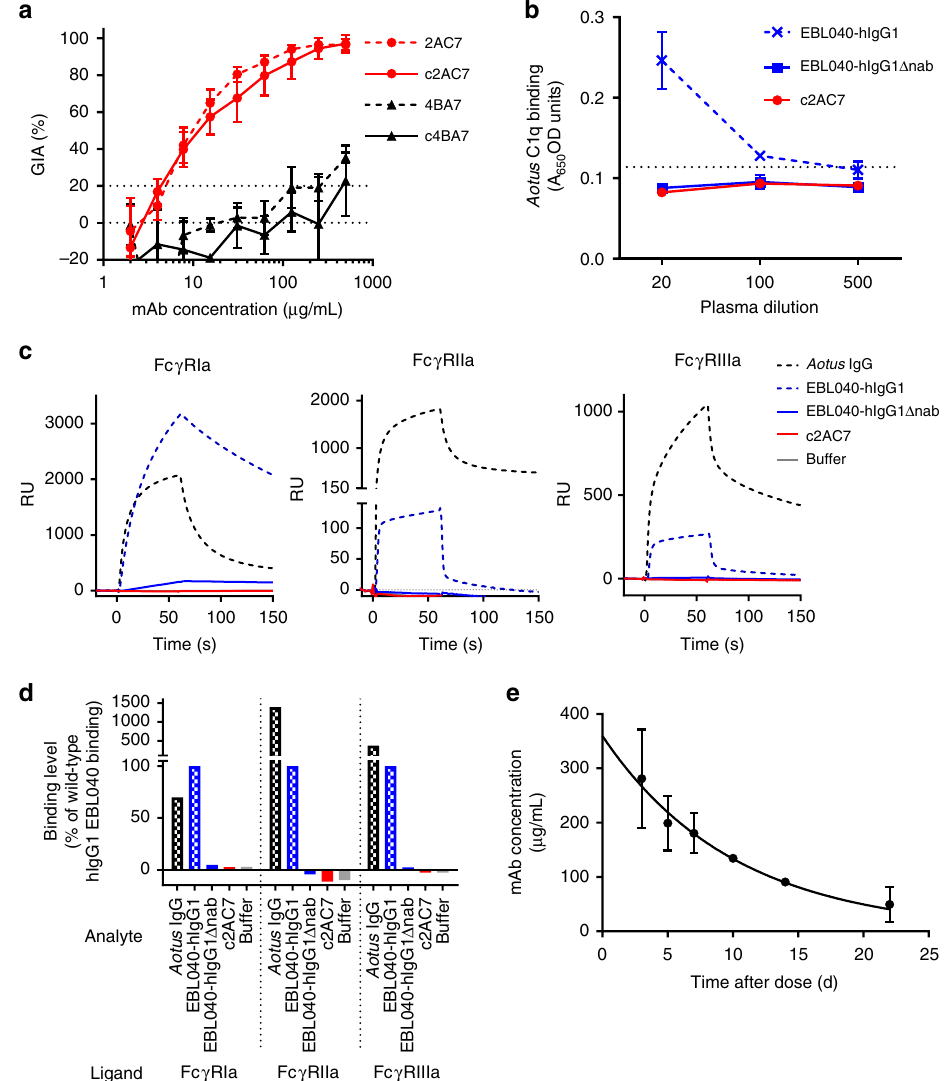
Fig. 1 Chimeric mAbs have desired properties for a challenge study. Panel a shows GIA with murine (dashed lines) and chimeric (solid lines) versions of 2AC7 (red lines) and 4BA7 (black lines) against FVO-strain parasites. Error bars indicate range of two independent experiments (with each experiment ’ s datum being the mean of three replicate wells); lines connect the mean of the experiments. Results of − 20 to 20% GIA are regarded as negative. Panel b shows absence of ELISA-detectable interaction of A. nancymaae C1q with mAbs bearing the hIgG1 Δ nab Fc. Horizontal dotted line indicates background (mean plus two standard deviations of control wells coated with mAbs but not receiving plasma); points and error bars indicate mean and range of two replicate wells per condition. Panels c and d show SPR data demonstrating that the hIgG1 Δ nab Fc abrogates binding to A. nancymaae Fc γ receptors. Panel c shows reference-subtracted (Fc2-1) binding-response curves for the injection of various antibody analytes (indicated by line characteristics, as shown in the legend to the right) over chips with Fc γ RIa (left), Fc γ RIIa (middle), and Fc γ RIIIa (right) ligands captured on Fc2; in each case, analyte is injected from 0 to 60 s. Panel d summarizes peak (60 s) binding of each antibody to each receptor, expressed as percentage of the response obtained on the same receptor with the wild-type human IgG1 mAb control (EBL040-hIgG1). Panel e shows results of preliminary pharmacokinetic study: anti-PfRH5 ELISA- measured plasma mAb concentrations from days 3 to 22 after administration of a single dose of 30 mg/kg c4BA7 to two A. nancymaae . Points are mean of two animals ’ results; error bars show the range, although are not visible where replicates were in close agreement. Line shown is the fi tted one-phase exponential decay